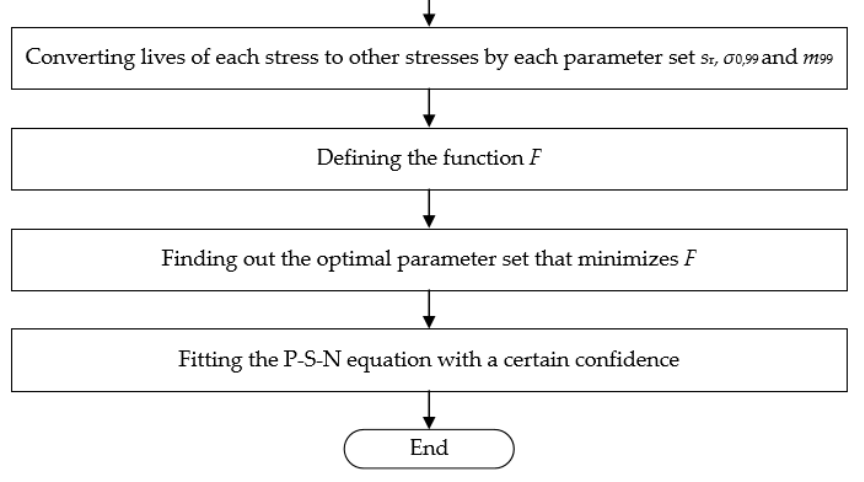
Figure 3. The flow chart of the IMLM.